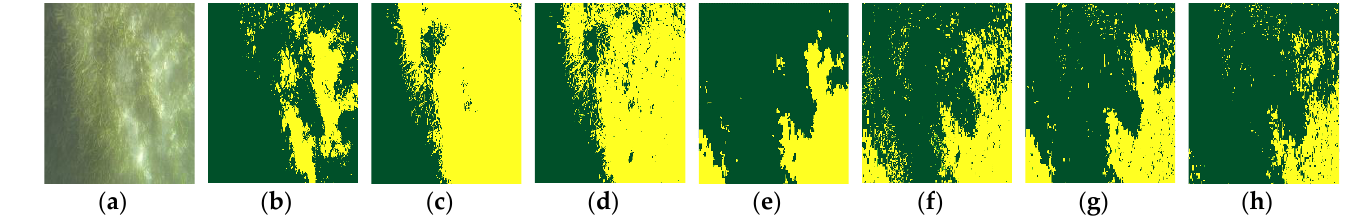
gray: corals, and yellow: sediments.